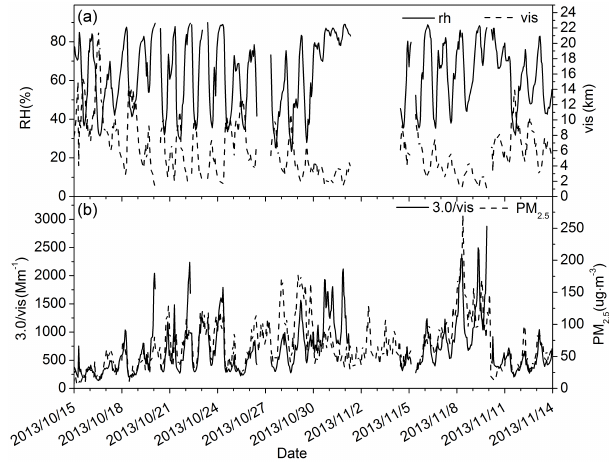
Figure 2. Time series of RH, visibility, extinction coefficient, and PM 2 . 5 during the observation period.